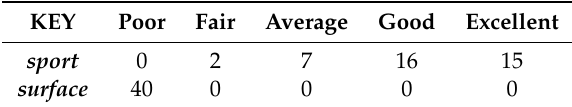
Table 13. Summary of compliance of all cities with suggested tag key combinations for the target tag leisure=pitch